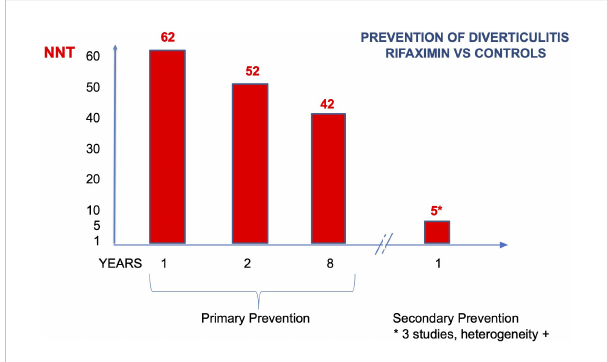
FIGURE 3 Number of patients who need to be treated to prevent diverticulitis (NNT) (primary and secondary